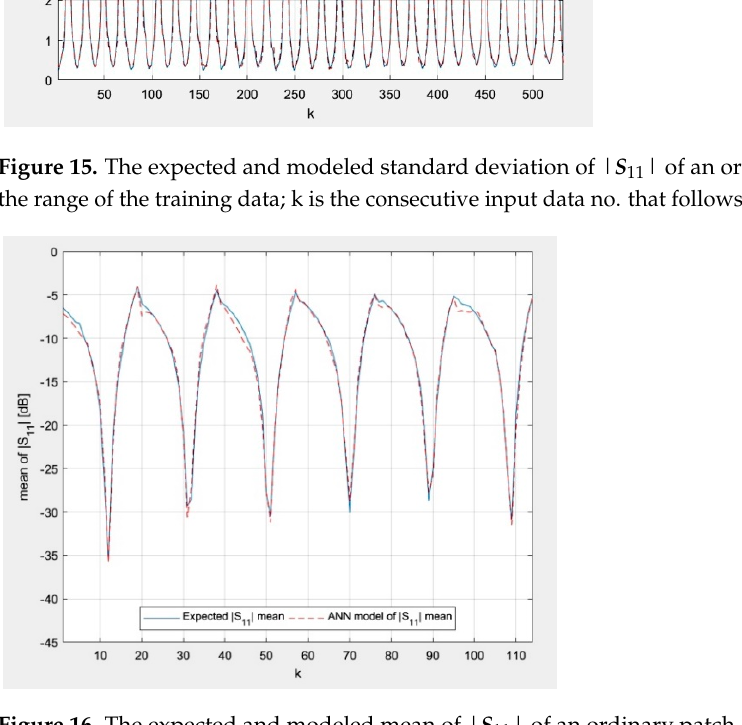
Figure 17. The expected and modeled standard deviation of | S 11 | of an ordinary patch antenna for the range of the first set of testing data. Finally, the expected and modeled mean and standard deviation of | S 11 | for the test- ing data corresponding to nominal values f 0 and w 0 equal 28.0 GHz and 3.71 mm, respec- tively, and 19 nominal values of y 0 with a 0.05 mm step are presented in Figures 18 and 19. Figure 18. The expected and modeled mean of | S 11 | of an ordinary patch antenna for the range of the second set of testing data.